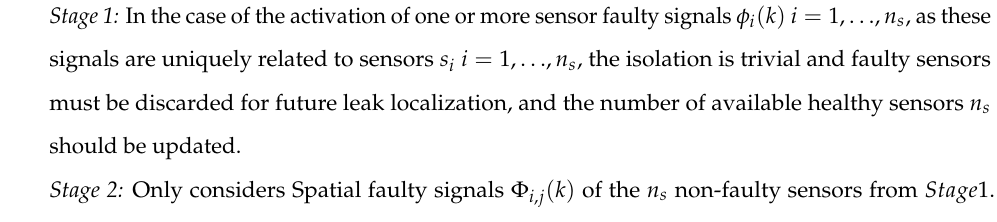
Algorithm 1 Sensor validation search for sensor fault